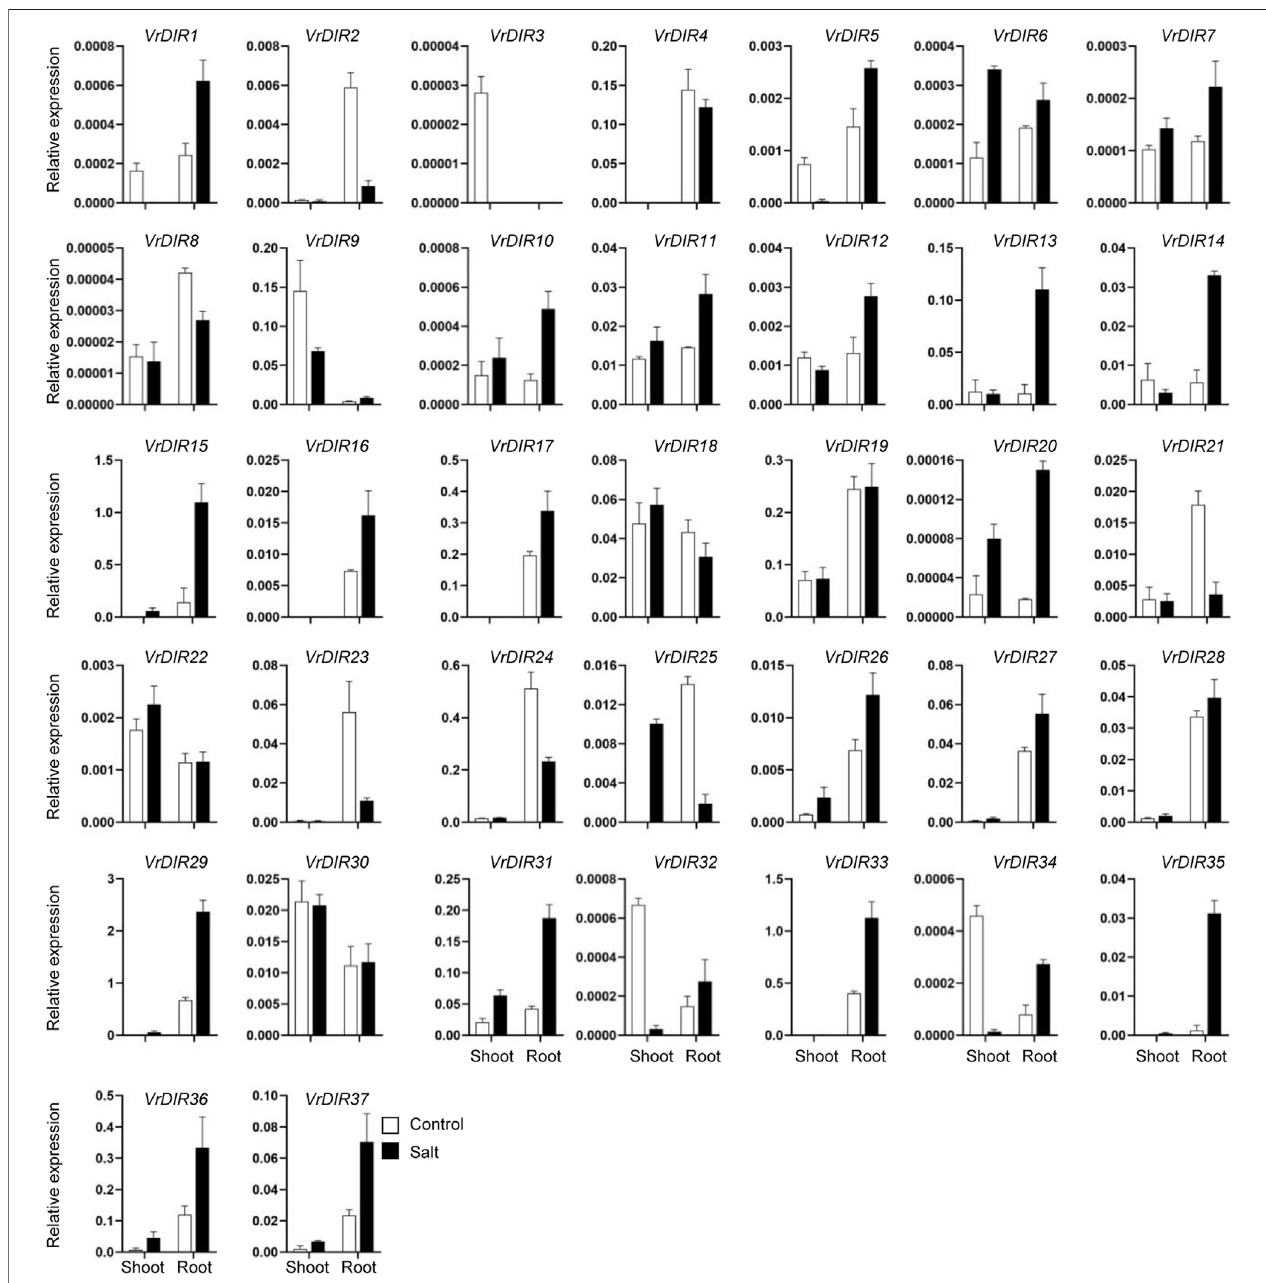
FIGURE8| Expressionlevelsof VrDIR genesinresponsetosaltstress.Theexpressionof VrDIR genesinshootsandrootsgrownundernormalandsaltconditions was analyzed using qRT-PCR. Each sample was analyzed using three biological replicates and normalized to an Actin -expressing gene in mungbean.